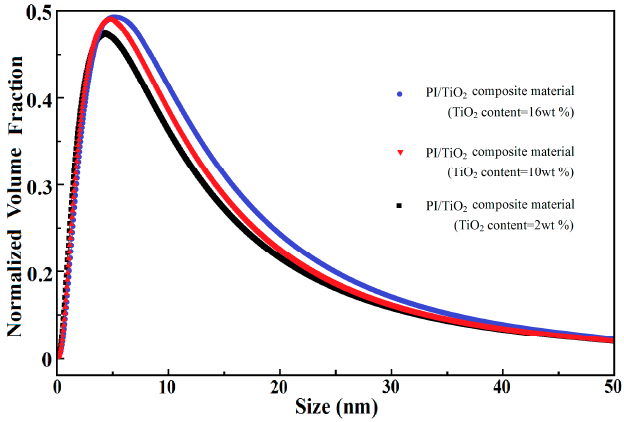
Figure 5. Size distributions of the TiO 2 component in the PI/TiO 2 composite material with different TiO 2 contents.